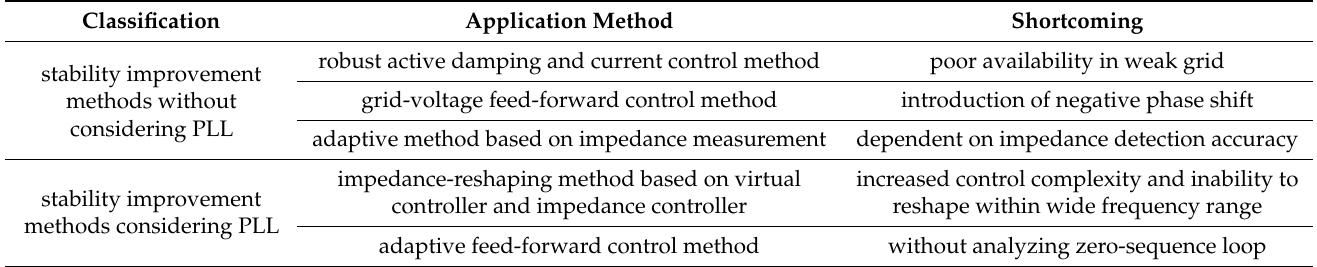
Table 1. Overview of the current research on inverter stability improvement